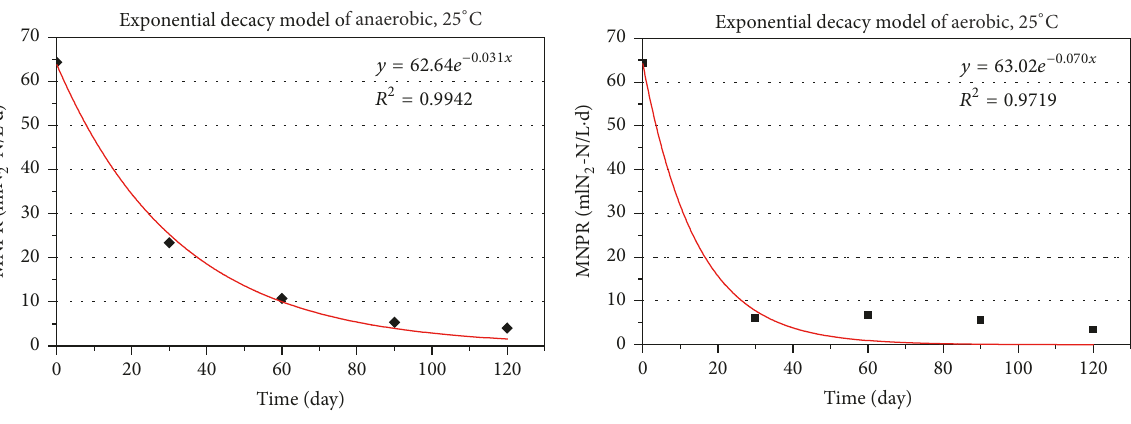
Figure 4: Fitting curves of NMPR during the decay period under different conditions.